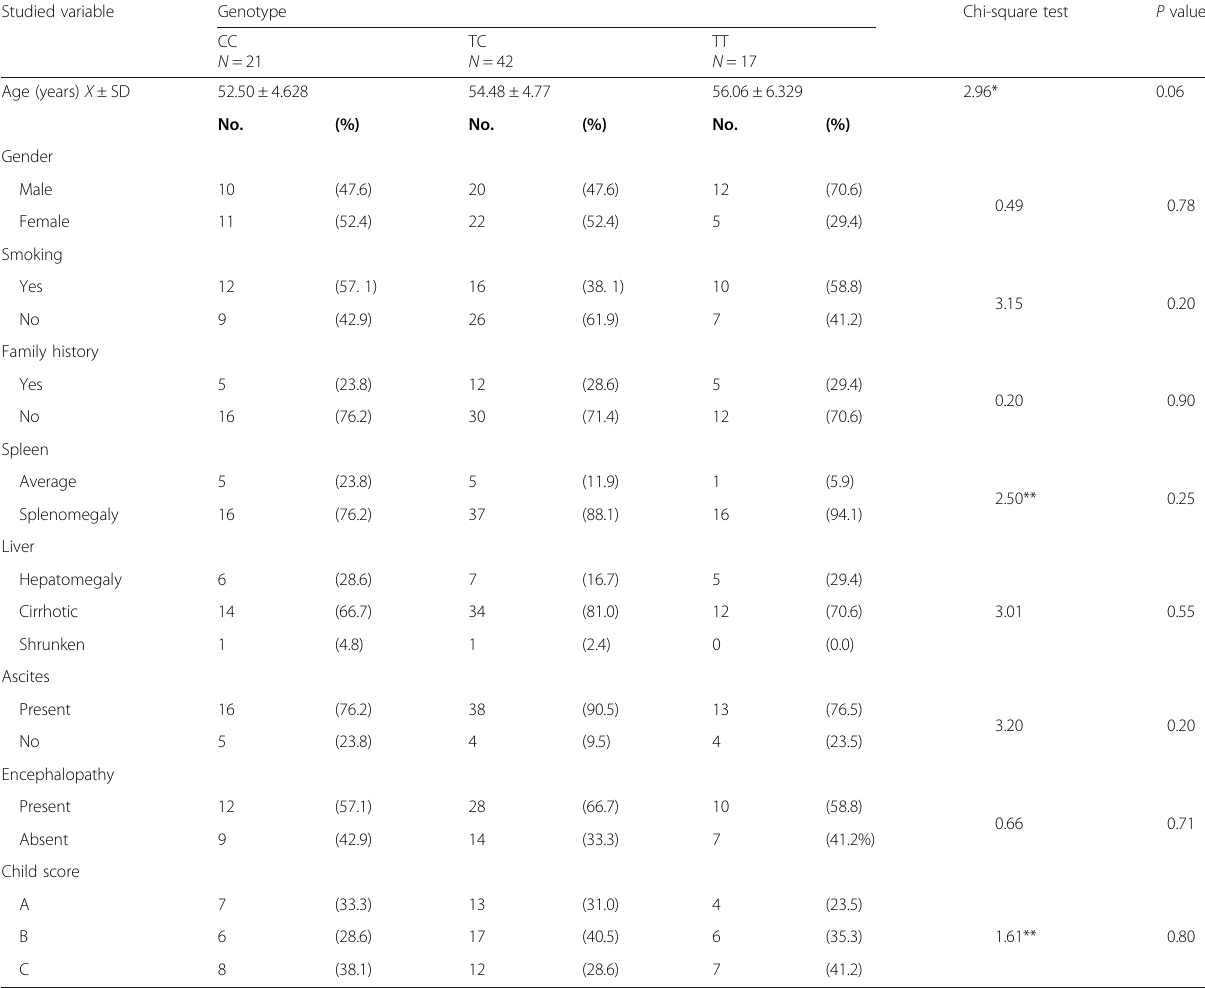
Table 6 Relation between genotypes and socio-demographic data among HCC patients Studied variable Genotype Chi-square